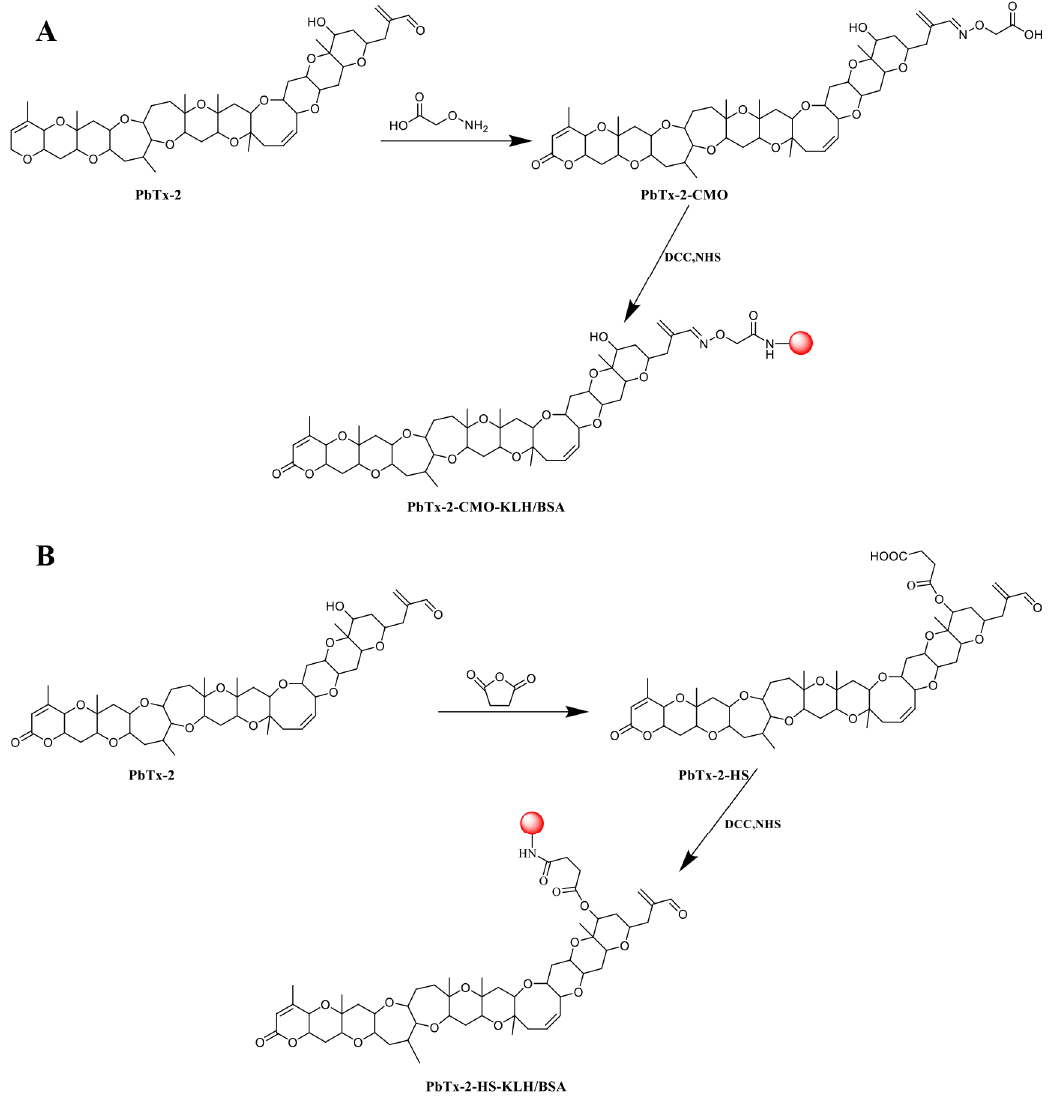
Figure 2. PbTx-2 hapten and antigen synthesis routes. ( A ) PbTx-2-CMO-KLH/BSA. ( B ) PbTx-2HS-KLH/BSA.